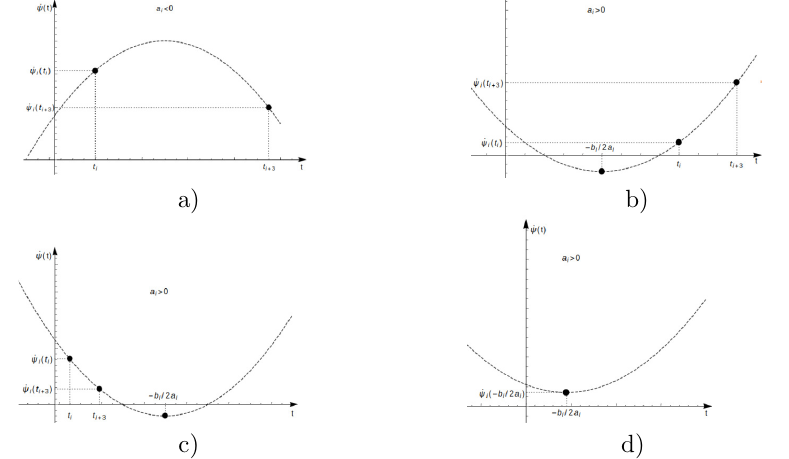
Figure 1. The plot of (4 . 1) with ˙ ψ i > 0 over [ t i ,t i +3 ] for: a) (i) , b) (ii) , c) (iii) & d) (iv)